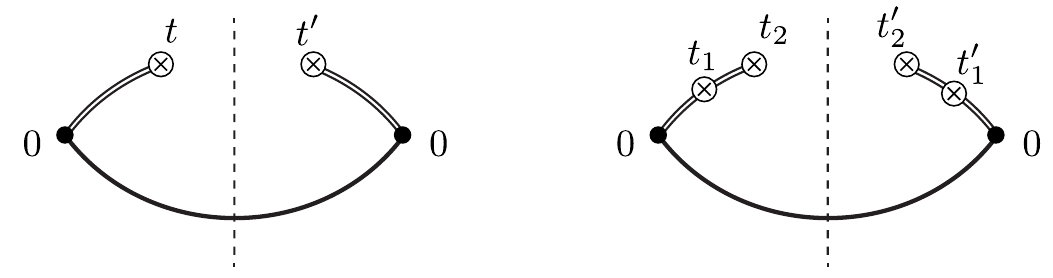
Figure 1 . Left: graphical representation of the gluon field strengths and Wilson lines of the integrand of eqs. (3.26) and (3.19). The symbols ⊗ represent insertions of gluon field strengths at the times t and t 0 . Right: graphical representation of the field strengths and Wilson lines of the integrand of eq. (3.32). The symbols ⊗ represent insertions of chromoelectric fields at the times t 1 , t 0 , t 2 , and t 0 . In both diagrams, filled circles represent the spacetime origin, double lines are 1 2 Schwinger lines, solid lines are gauge-completion Wilson lines in the ‘ direction, and the dashed line is the